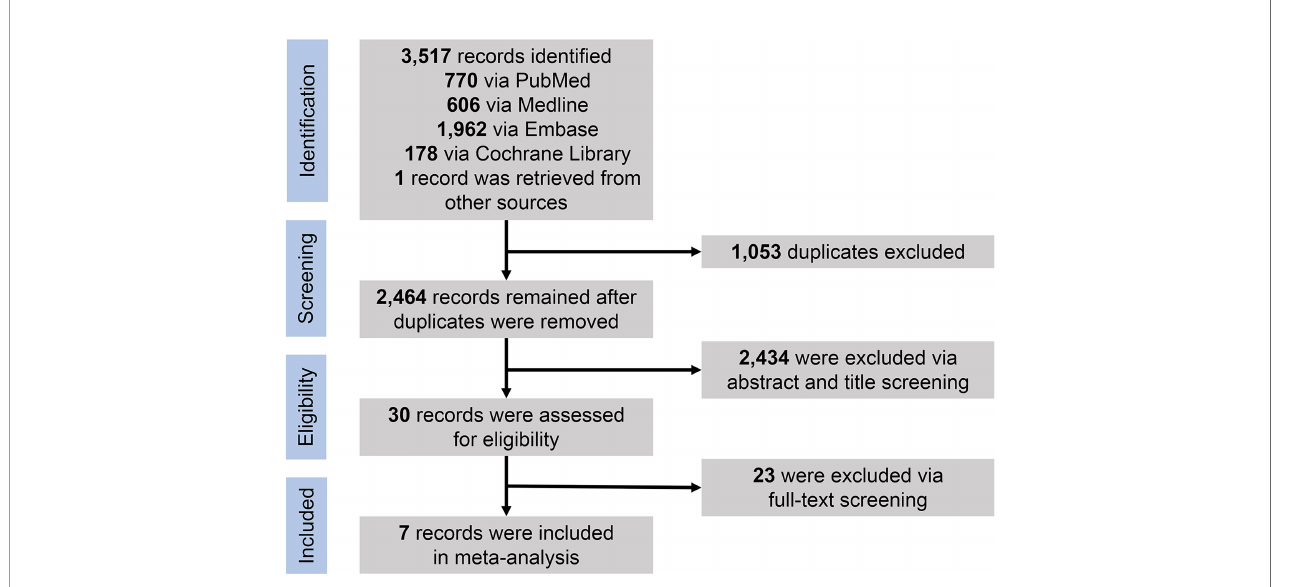
FIGURE 1 | PRISMA fl owchart for selection of studies. PRISMA, Preferred Reporting Items for Systematic Reviews and